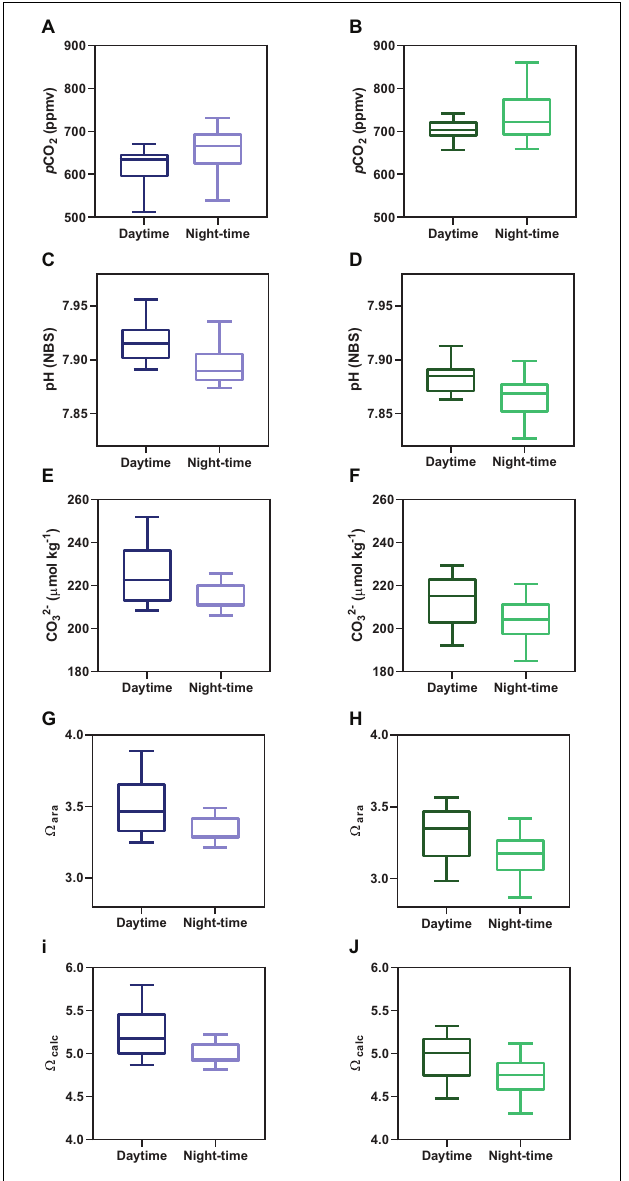
FIGURE 4 | Comparison between daytime and night-time averaged concentrations for the main carbonate chemistry parameters, which are p CO 2 (A,B) , pH (C,D) , CO 32 − (E,F) , (cid:127) ara (G,H) , and (cid:127) calc (I,J) . Graphs on the left side represent Oct-2017; graphs on the right side represent Sep-2018. of FCO 2 were lower during night-time (54.1 mmolC m − 2 d − 1 )